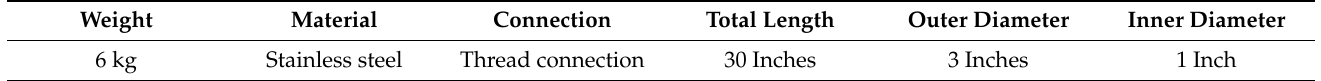
Figure 5. Permanent magnet utilized in magnetizing the water. Table 4. Permanent magnet dimension and description.